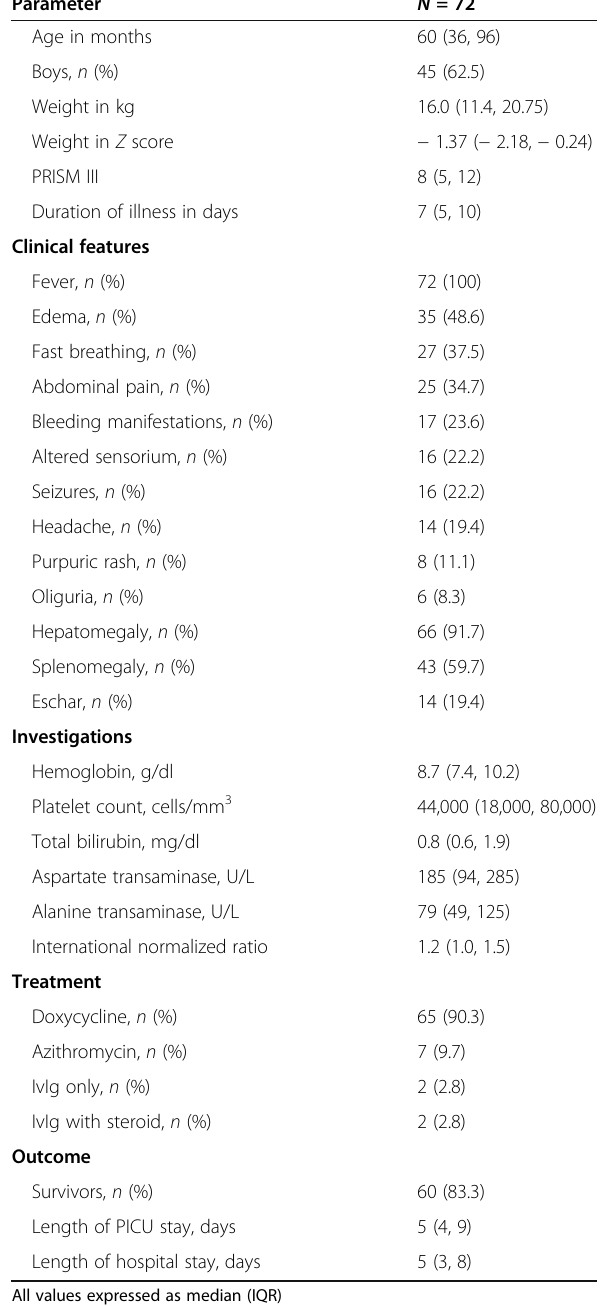
Table 1 Clinical profile, investigations, and